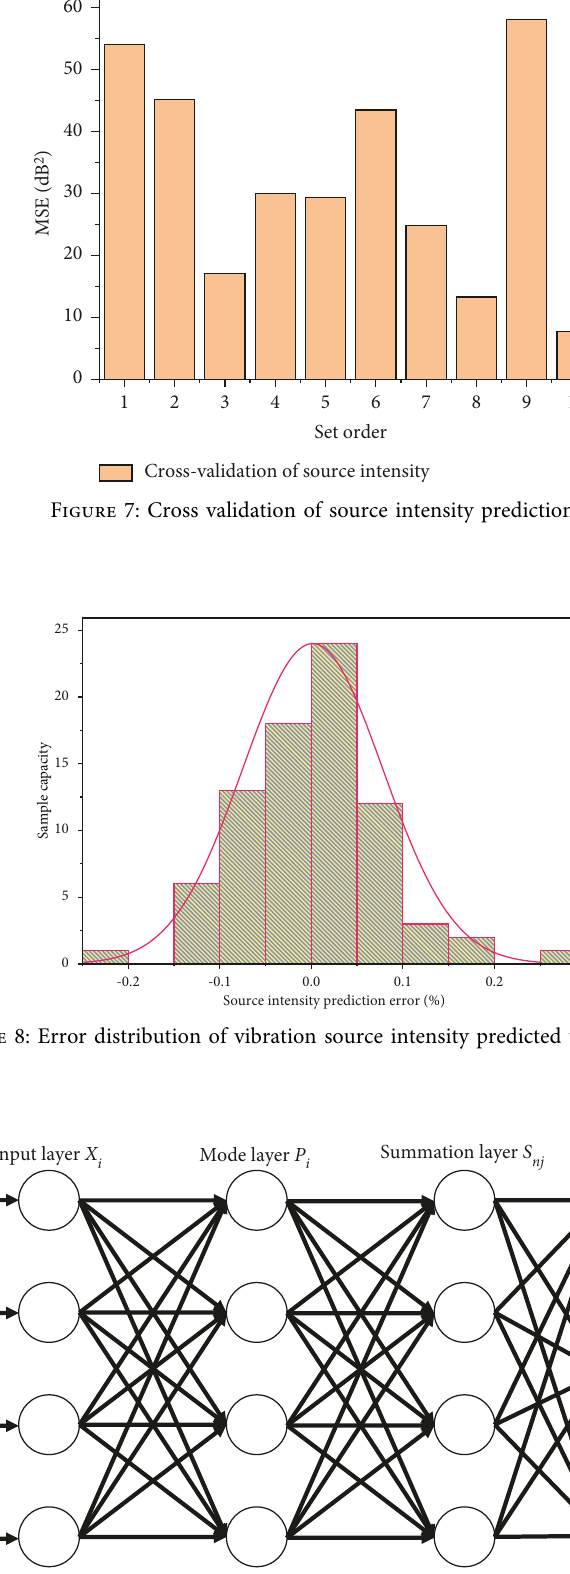
Figure 9: Topology of